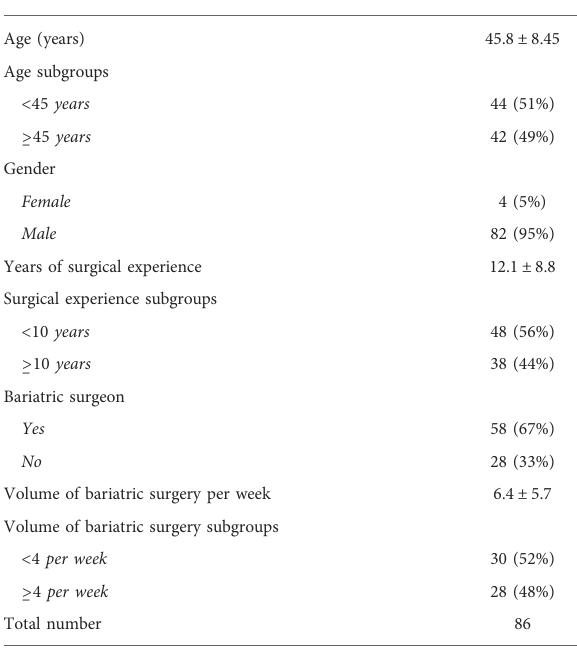
TABLE 1 General characteristics of